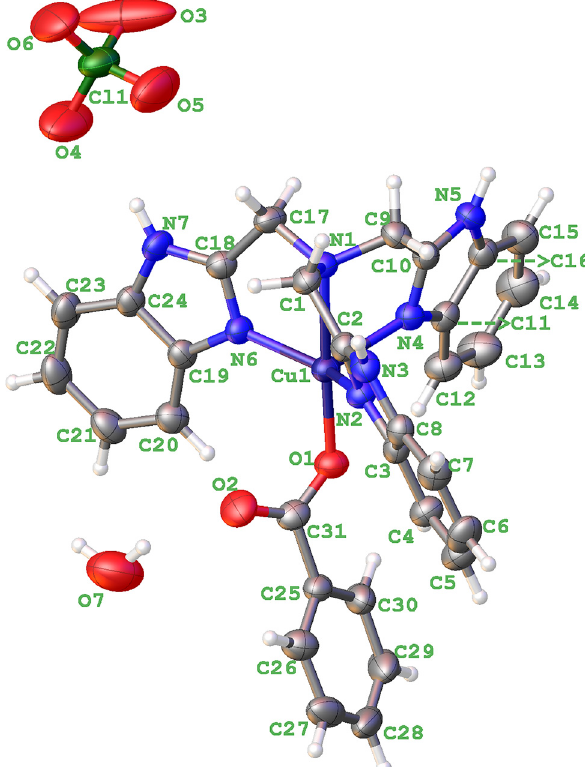
Table 1 contains crystallographic data and Table 2 contains the list of the atoms including atomic coordinates and displacement parameters.